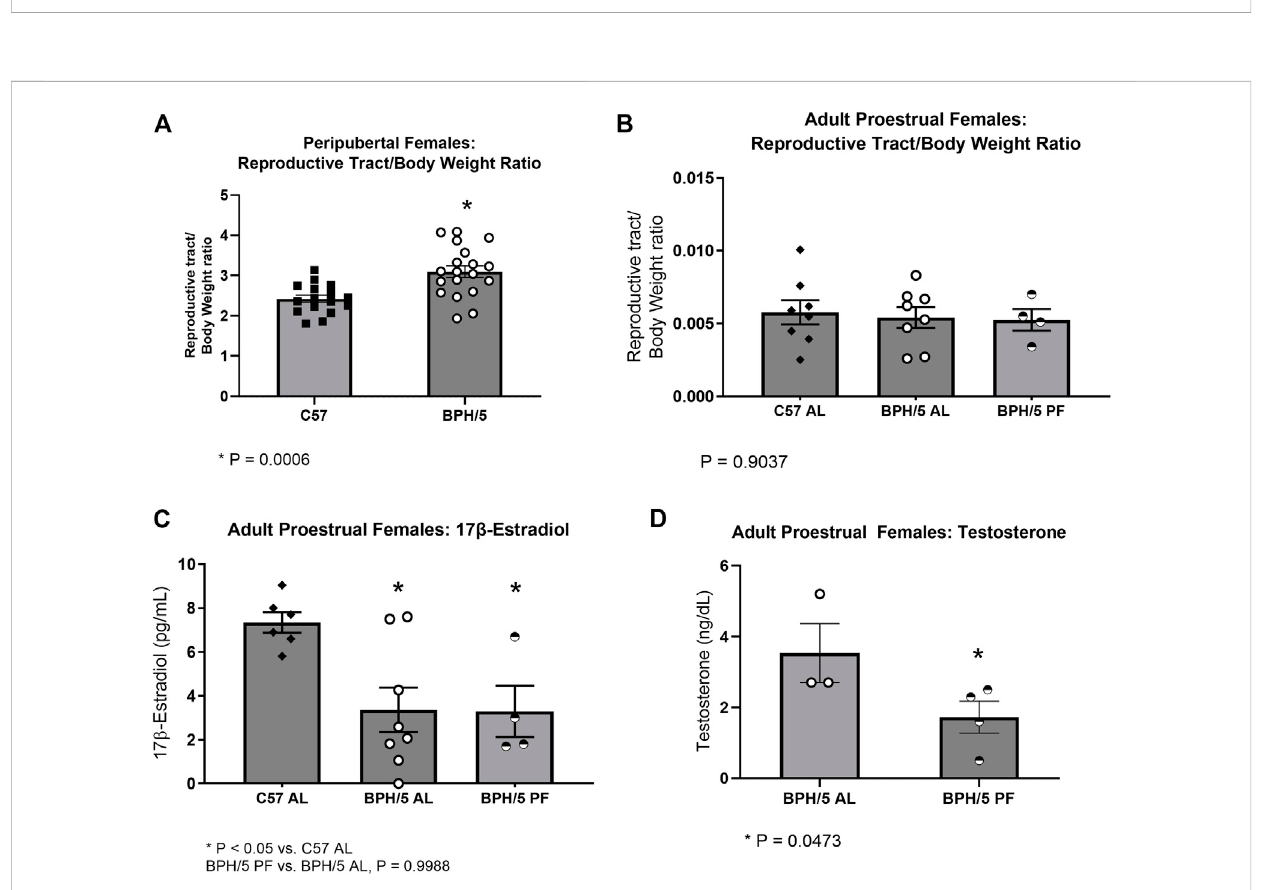
FIGURE 3 Female BPH/5 offspring present hyperandrogenism during adulthood, which is attenuatedby dietary weight loss. (A) Reproductive tract wet weight corrected to body weight (BW) in peripubertal BPH/5 and C57 females ( n = 16 – 19/group, Student ’ s t-test, mean ± SEM, * p = 0.0006). (B,C) As previously reported (Sutton et al., 2017), adult ad libitum-fed BPH/5 females (BPH/5 AL) present lower serum 17 β -estradiol and similar uterine wet weight to ad libitum-fed C57 (C57 AL) during proestrus. In this study, (B) reproductive tract/body weight ratio and (C) serum 17 β -estradiol were unchanged in proestrual pair-fed BPH/5 females (BPH/5 PF) vs. BPH/5 AL females ( n = 4 – 8/group, One-way ANOVA and post hoc Tukey ’ s test, mean ± SEM, * p < 0.05 vs. C57 AL). (D) Serum testosterone concentration was below the assay detection limit of 2 ng/dL in proestrual C57 AL. Serum testosterone concentrationwas detected inproestrualBPH/5 ALfemalesand wasattenuatedinBPH/5 PFfemales( n = 3 – 4/group,Student ’ st-test, mean ± SEM,* p =